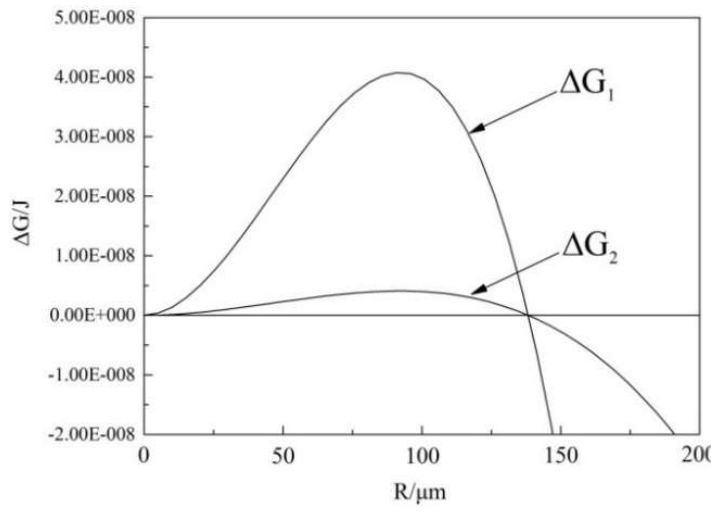
Figure 11. The changes in Gibbs free energy of bubble homogeneous nucleation and heterogeneous nucleation under same conditions.